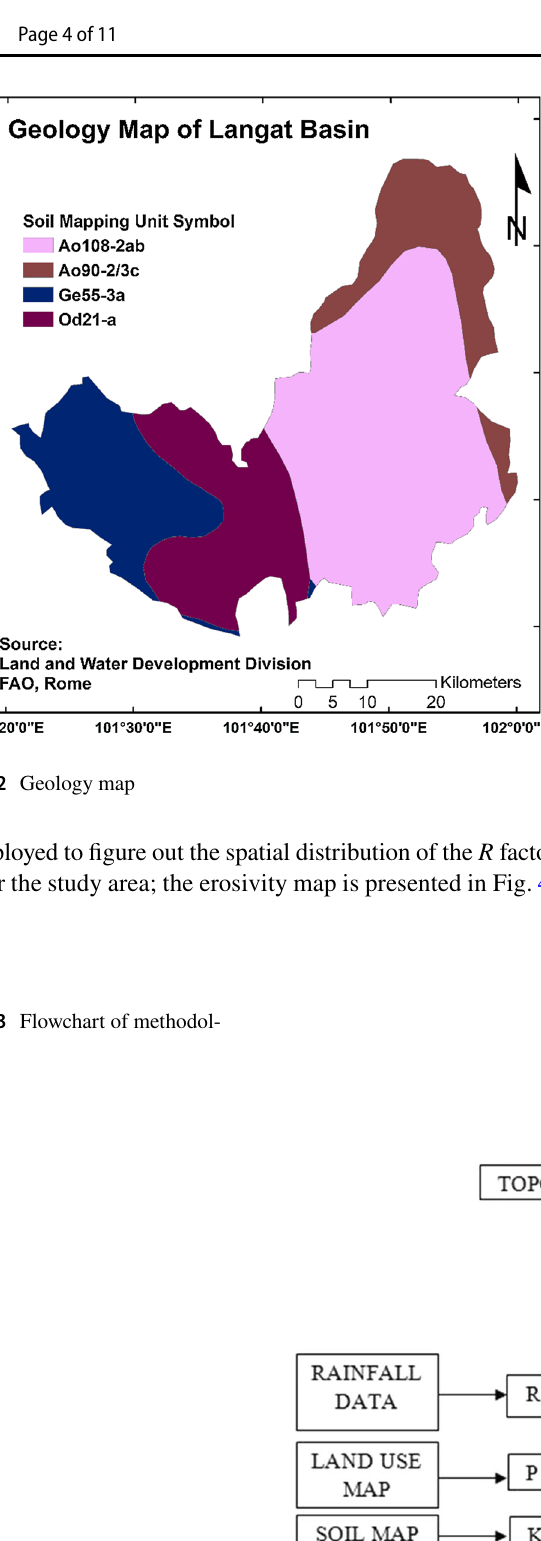
Fig. 3 Flowchart of methodol-